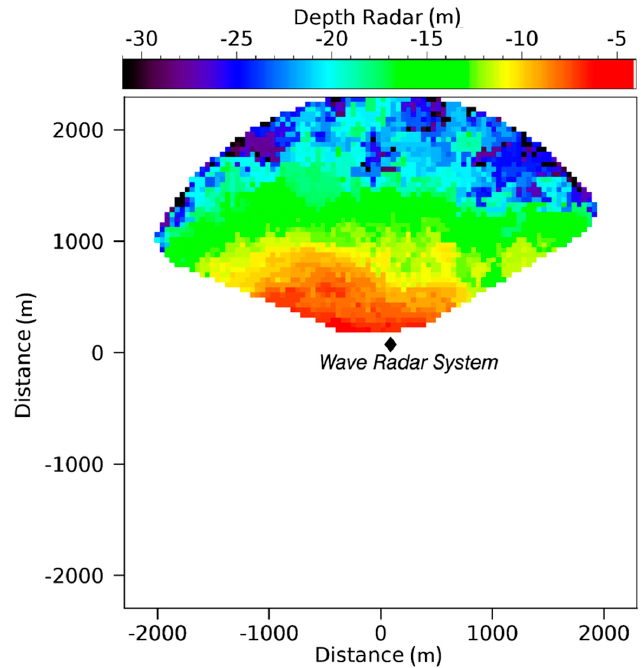
Figure 2. Bathymetry map of the investigated area.